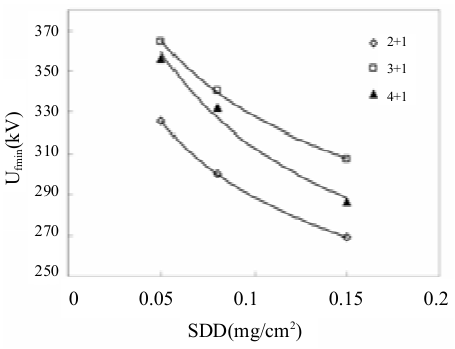
Figure 27. The relationship of CALSDS arrangement icing flashover voltage and SDD [59]. For II arrangement, increasing the distance between the two insulators can improve flashover voltage performance. When the distance increases from 450 to 650 mm, the flashover voltage of the standard insulator string and with large shed increases by 3.2% and 7.1%, respectively [60]. When the string connection angle widely used in the transmission line is 60 ◦ , the flashover situation of the insulator string of V and Λ shape arrangement under wet snow conditions is shown in Figure 28 [60].